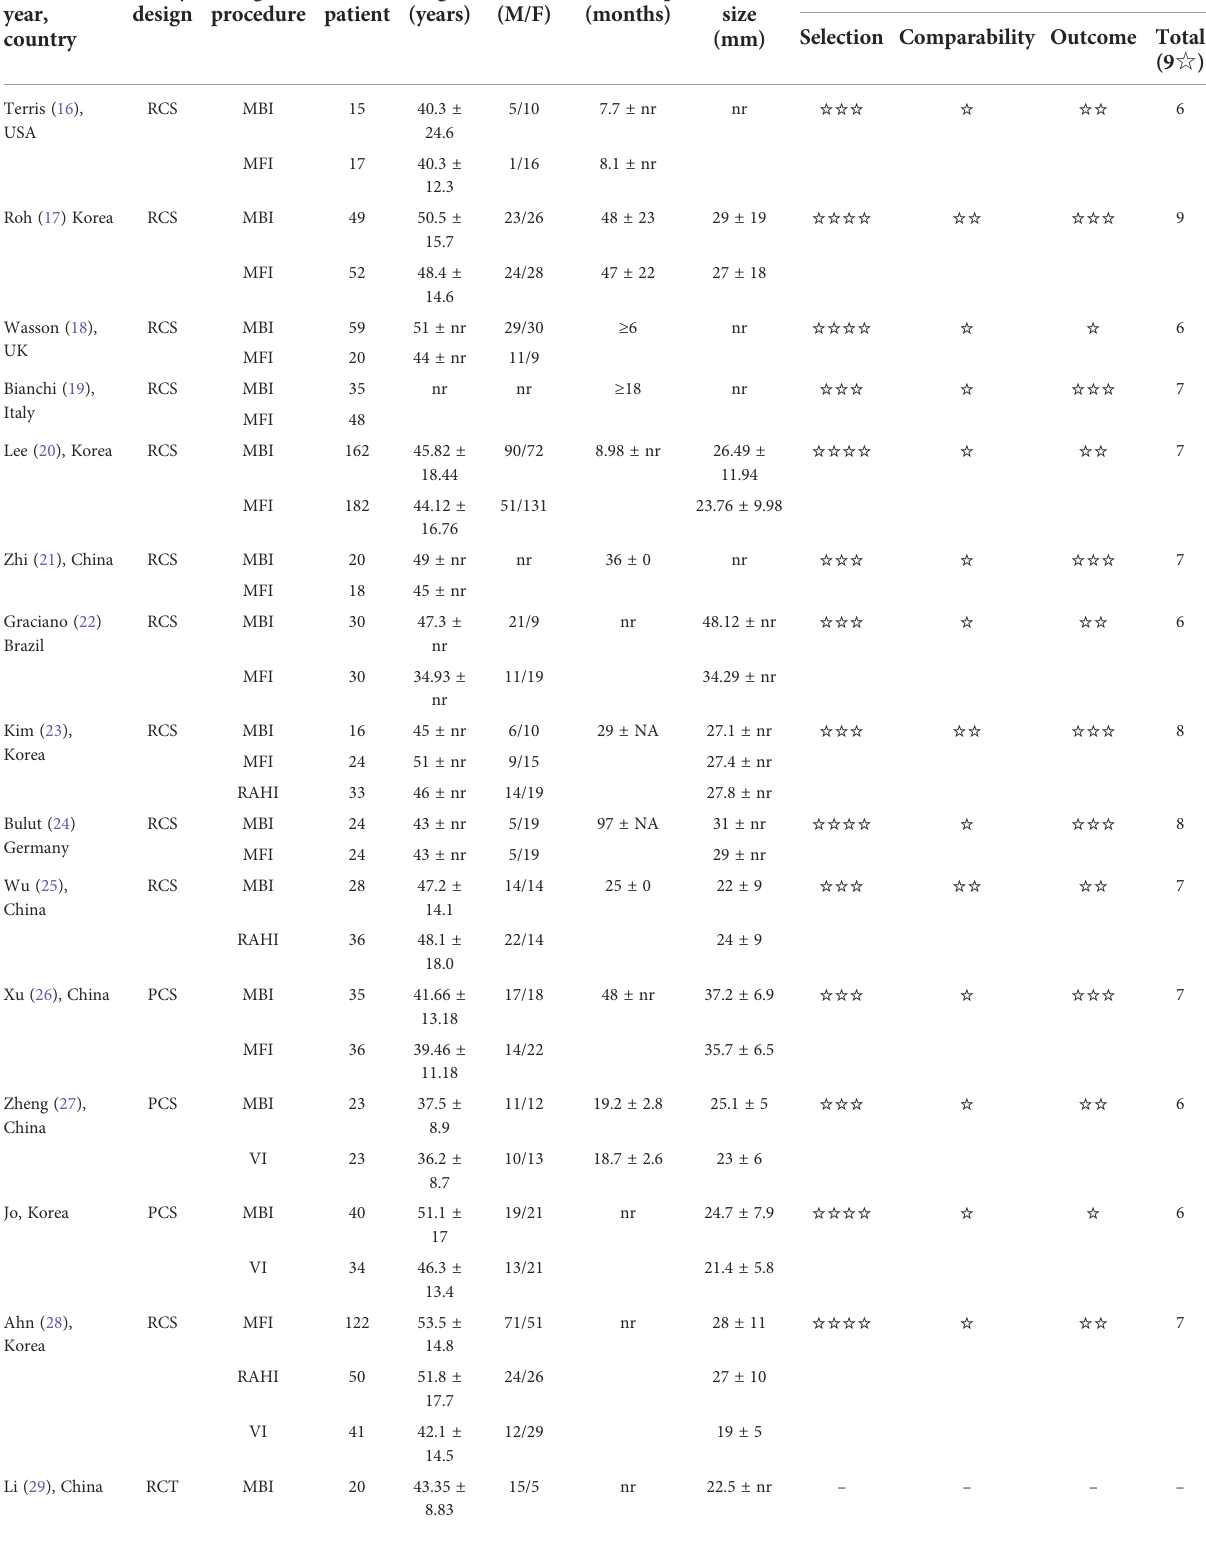
TABLE 1 Characteristics and NOS quality assessment of the included